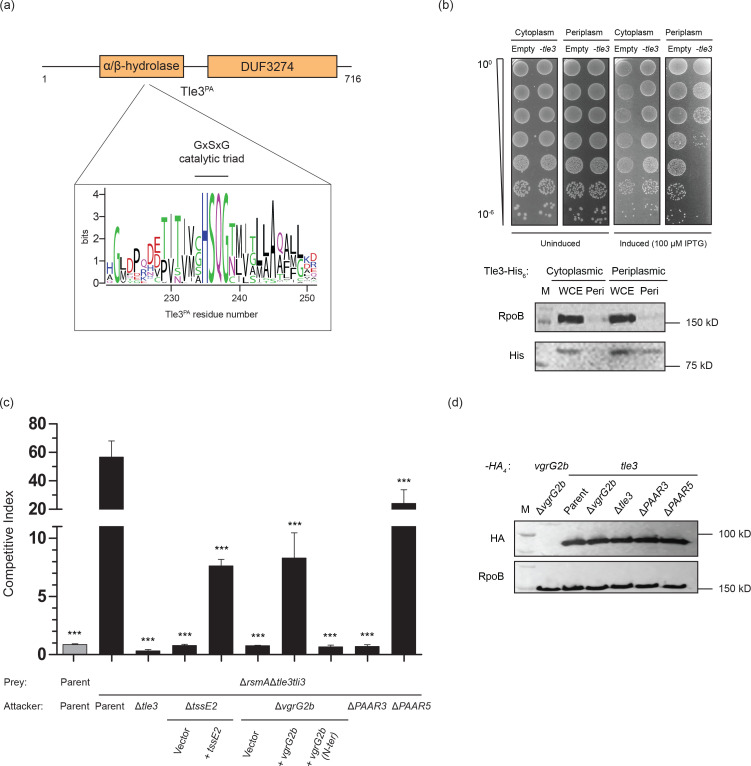
Tle3 is a periplasmic antibacterial toxin delivered by the VgrG2b-PAAR3 spike complex. (a) Domain schematic of the Tle3 protein from
P. aeruginosa
 depicting the α/β-hydrolase and DUF3274 domains. A sequence logo of the predicted GXSXG consensus esterase motif of homologous proteins is shown below. (b) Heterologous production of Tle3 is toxic to
E. coli
 when targeted to the periplasm. Upper panel: Serial dilutions of
E. coli
 BL21 (λDE3) carrying pET28a-tle3 or pET22b-tle3 (for cytoplasmic or periplasmic effector production, respectively) or the empty vector equivalents were spotted on non-inducing (2 % glucose) and inducing (100 µM IPTG) media. The range of OD600 values for the inoculum is stated on the left. Lower panel: Immunoblot analysis of Tle3 production in the desired bacterial compartment. Whole cell extracts (WCE) and periplasmic fractions of
E. coli
 BL21 (λDE3) pET28a-tle3 and pET22b-tle3 after growth in inducing conditions were probed using anti-His antibodies to detect the hexahistidine-tagged Tle3 protein. Antibodies against the RNA polymerase β-subunit RpoB were utilised to confirm no cytoplasmic contamination of the periplasmic fraction. Images are representative of three independent experiments. (c) Intraspecies competitive growth assay between a
P. aeruginosa
 prey strain lacking the tle3-tli3 cassette and various attacker strains. The competition index indicates the change in the attacker/prey strain ratio at the end of the assay relative to the input, where a value >1 represents a growth advantage to the attacker strain. Competition between the parental strain PAO1ΔrsmA and itself, shown in grey, acts as the internal control for competitive parity. Values denote the mean of three independent experiments, with error bars displaying the sem. Statistical significance of growth outcomes was determined by a one-way ANOVA followed by Dunnett’s multiple comparisons test, using the competition between the ΔrsmAΔtle3tli3 prey strain and the ΔrsmA parental strain as the comparator (*** p < 0.001). (d) Immunoblot showing the production of Tle3 in
P. aeruginosa
 strains. The VgrG2b-HA4 construct acts as an antibody control, while RpoB is a loading control. Images are representative of three independent experiments.